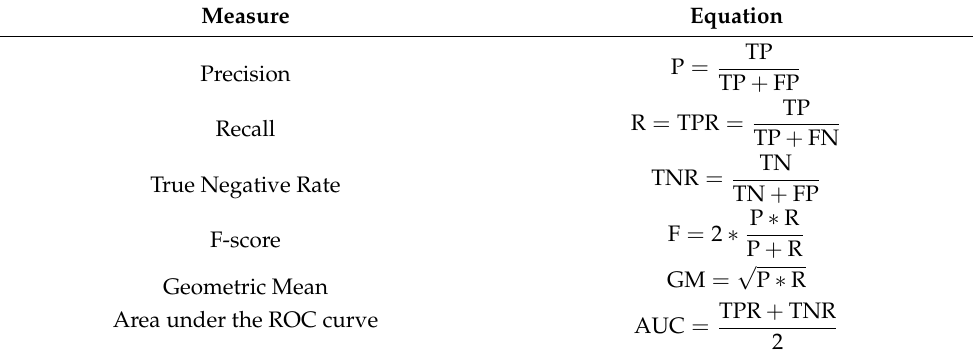
Table 3. Performance measures used.